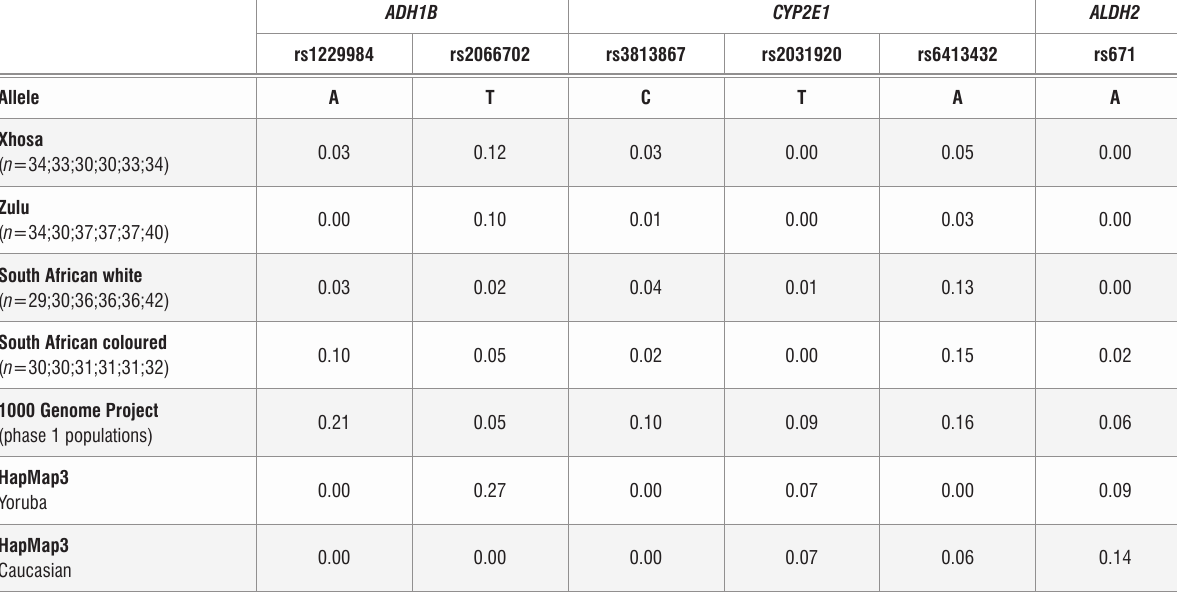
1000 Genome Project (phase 1 populations)